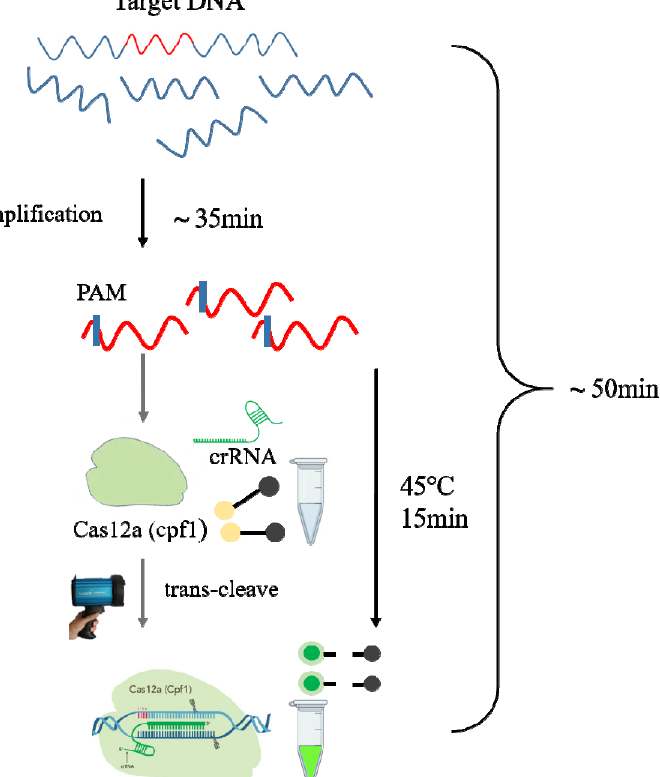
Figure 1. A T-nos detection method combining conventional PCR amplification with the CRISPR/Cas12a assay. The target DNA is specifically amplified by conventional PCR, and a crRNA guide sequence is specially designed targeting a region in the target DNA. The amplified product is added to the CRISPR bulk assay, which activates the trans-cleavage function of the Cas12a enzyme, resulting in cleavage of the quenched fluorescent ssDNA reporter if the target DNA is present, and hence in-tube fluorescence.